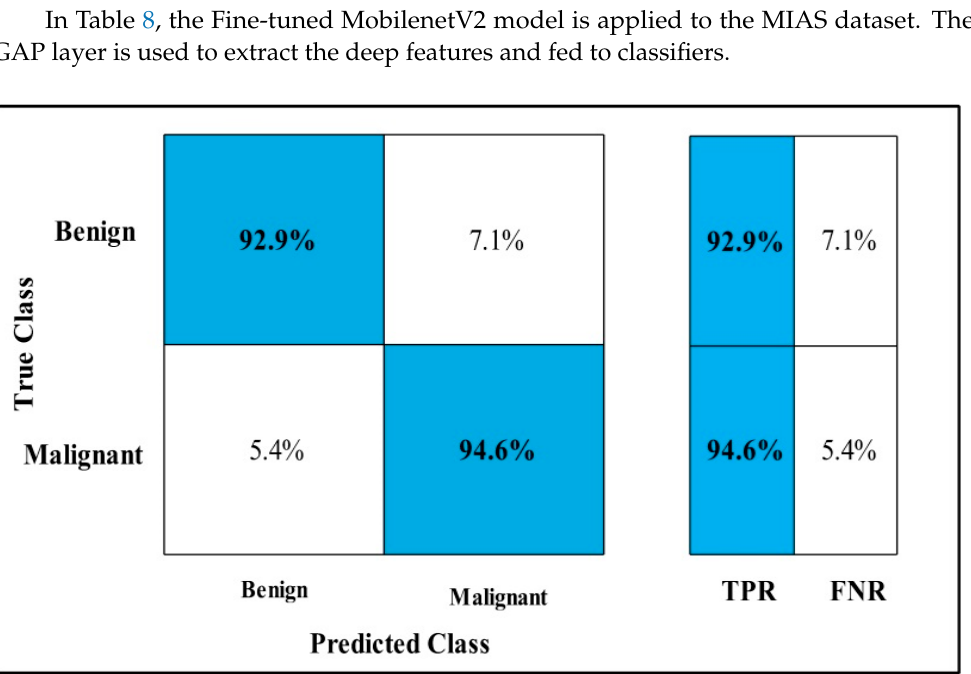
Figure 13. Time comparison with individual machine learning classifiers of deep learning models for CBIS-DDSM. In Table 8, the Fine-tuned MobilenetV2 model is applied to the MIAS dataset. The GAP layer is used to extract the deep features and fed to classifiers. The highest accuracy is 99.4%, which is achieved by the Cubic SVM classifier in 85.29 (s). In this table, the minimum time is taken by Fine Tree, which is 22.82 (s), but the ac- curacy is 88.9%, which is less than Cubic SVM.